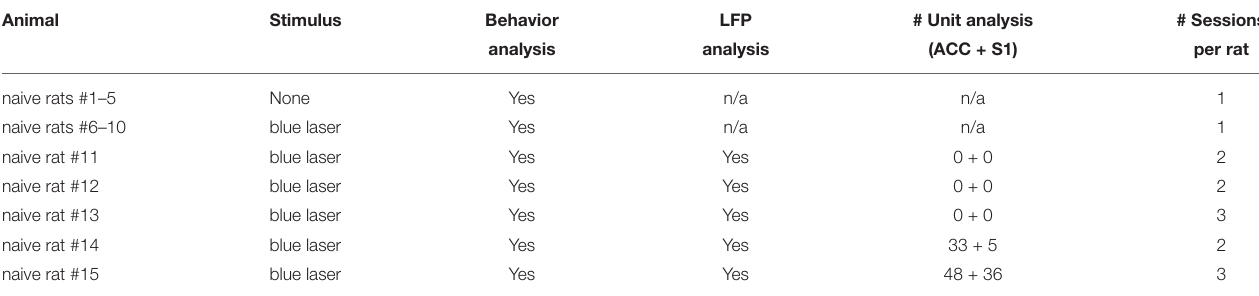
TABLE 1 | Summary of experimental data.